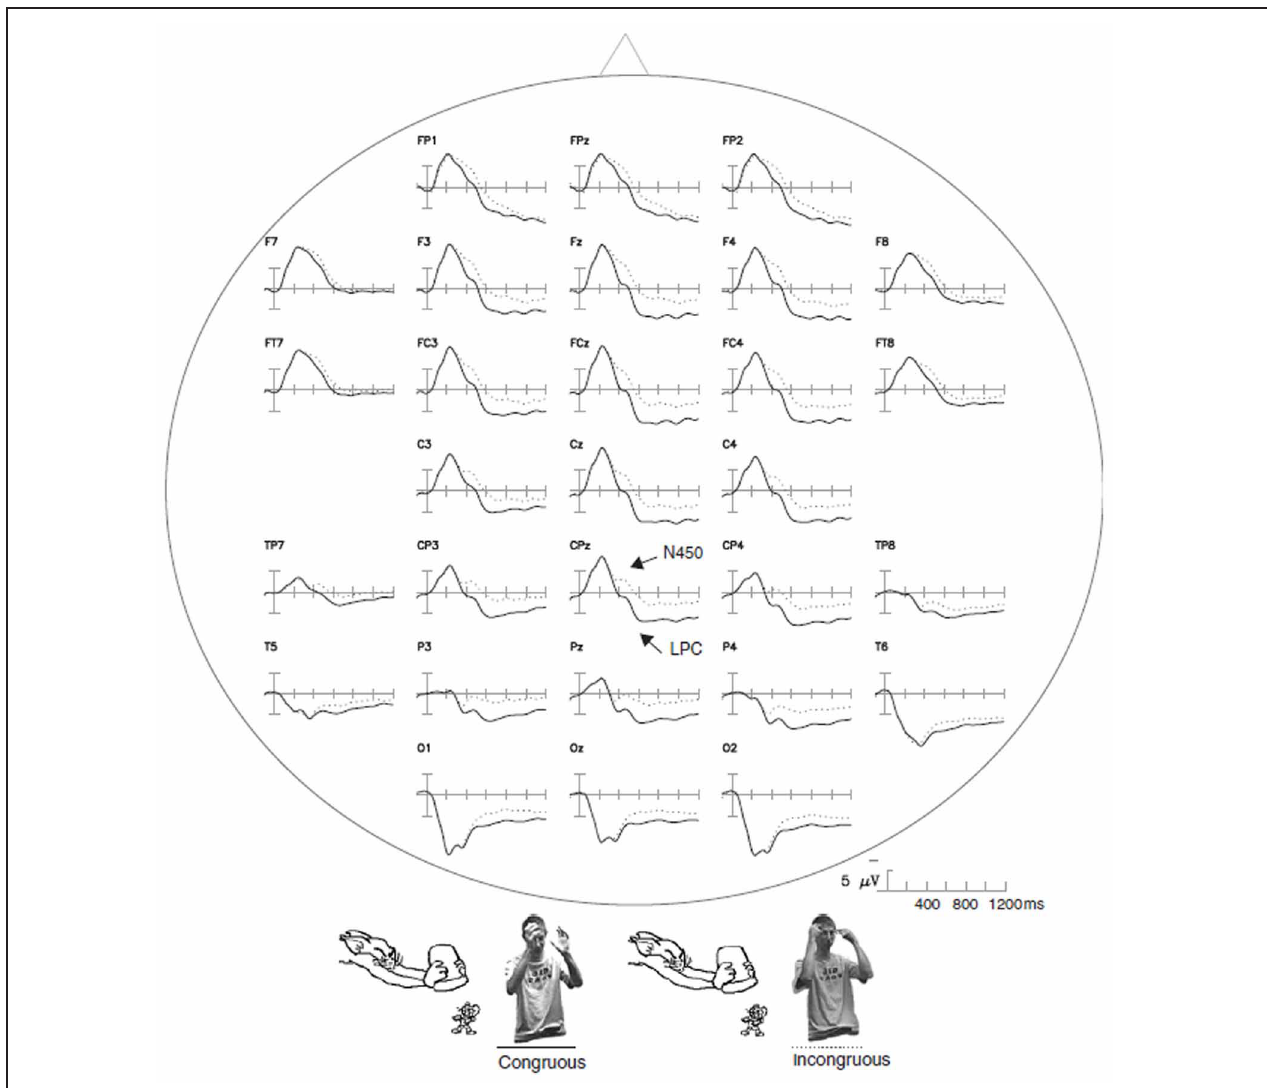
FIGURE 3 | The ERP waveforms for gestures embedded in complex contexts. The ERP responses time-locked to the onset of congruous and incongruous gestures paired with video segments of cartoons are